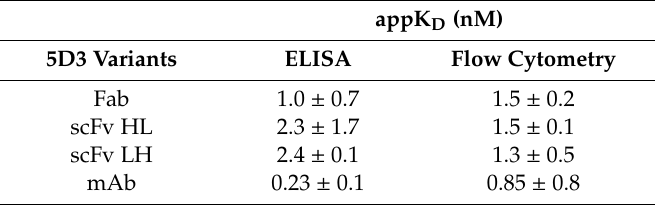
Table 1. Apparent K D of antibody fragments determined by native ELISA and flow